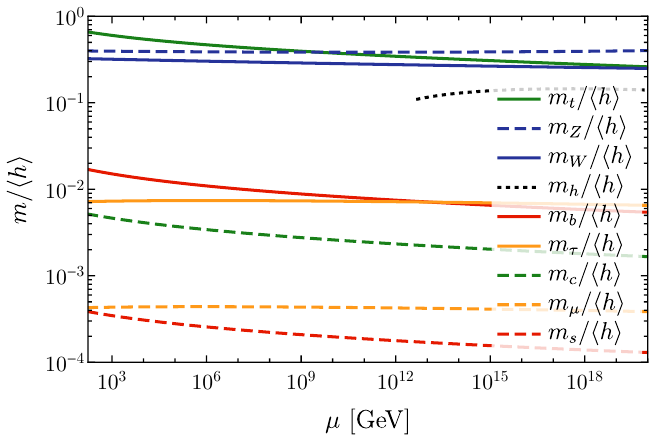
Figure 2 . RG (cid:13)ow of the coe(cid:14)cients of the masses of the SM particles in terms of the Higgs vev. The width of the lines in this plot is the larger than the current experimental uncertainty on the SM parameters at the weak